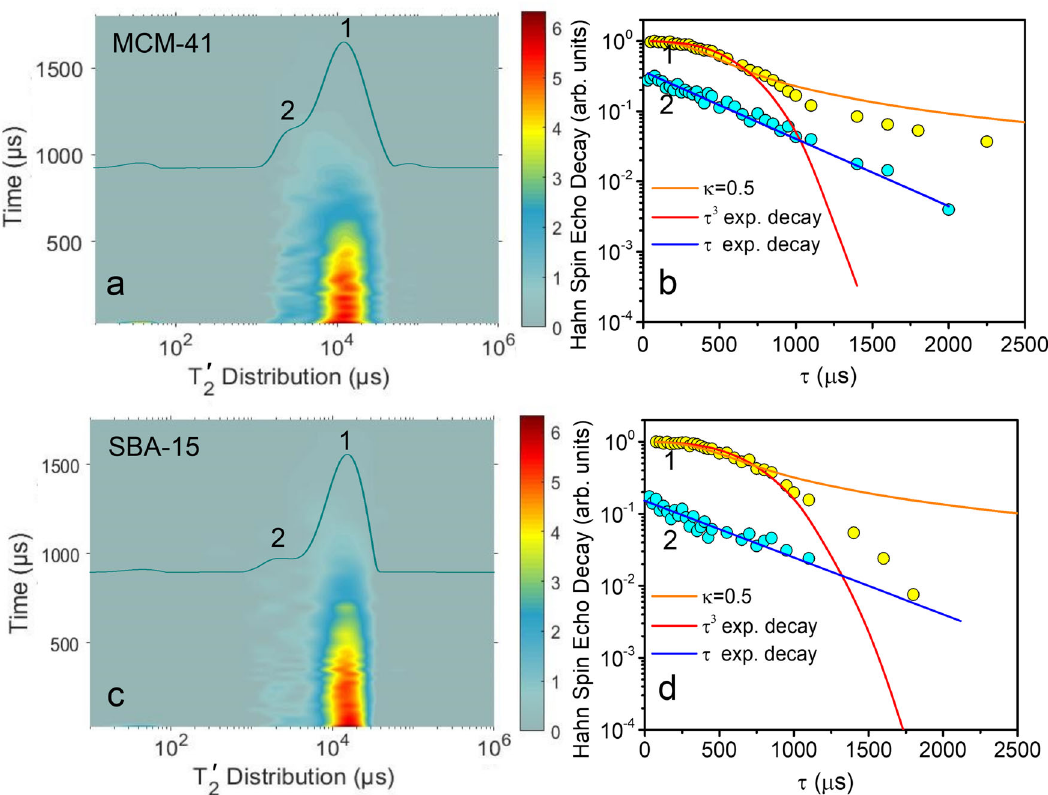
distribution of 2 -axis. b The Hahn SED vs. τ of signals 1 and 2 in Fig. 2a. 2 -axis. As previously, the two 2